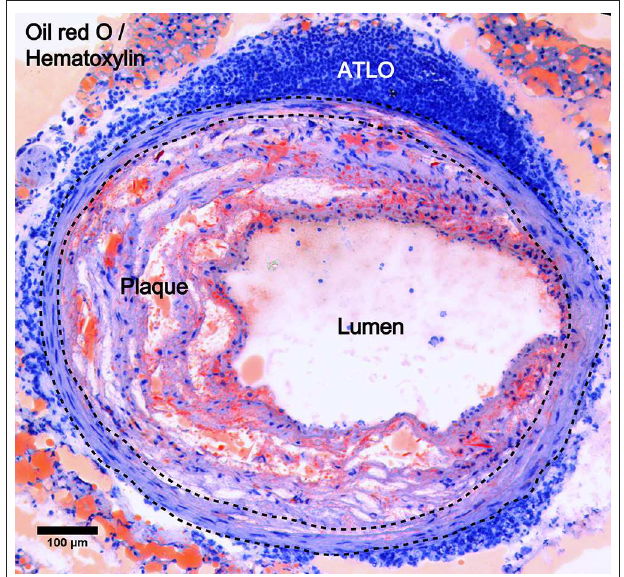
FIGURE 2 | ATLO location in atherosclerotic aorta. Oil red O/Hematoxylin staining showing ATLO position in the abdominal aorta adventitia relative to media (dashed lines) and intimal plaque in aged Apoe − / −